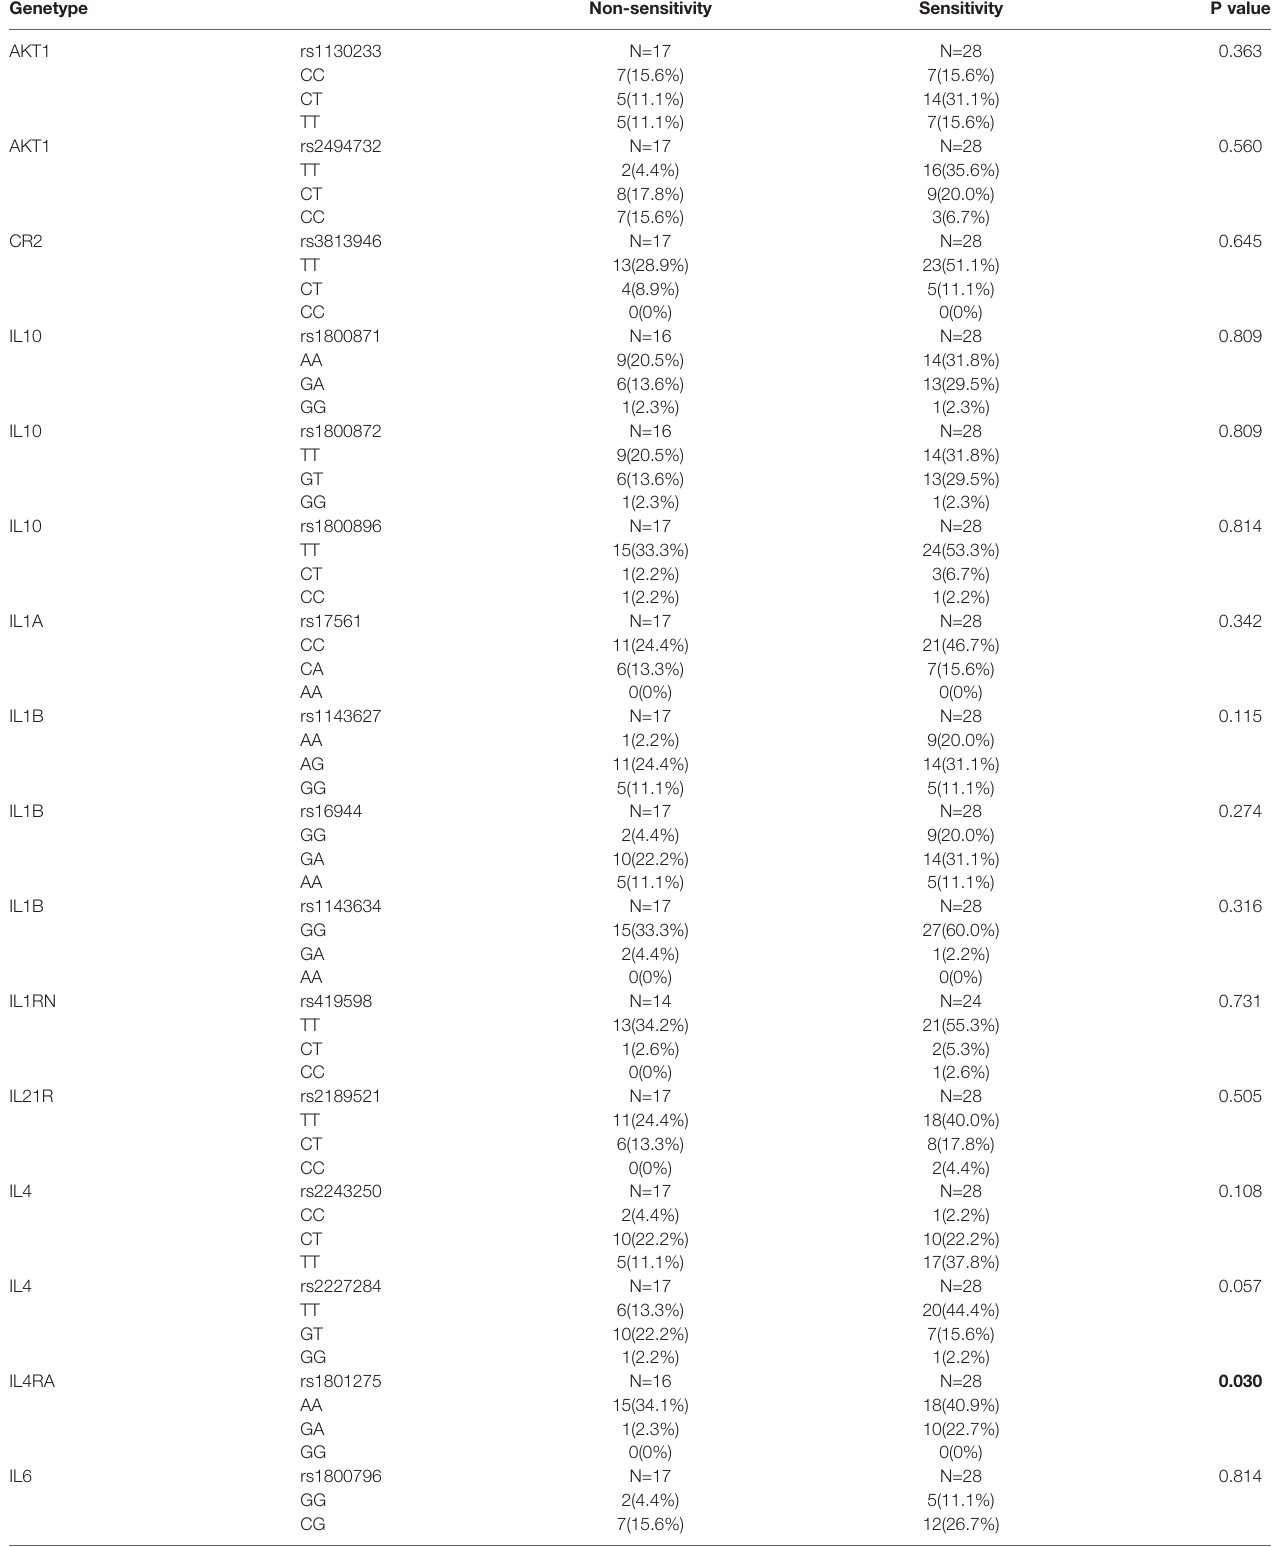
TABLE 4 | Association of 28 in fl ammation-associated gene SNPs with radiotherapy sensitivity of HNSCC patients.